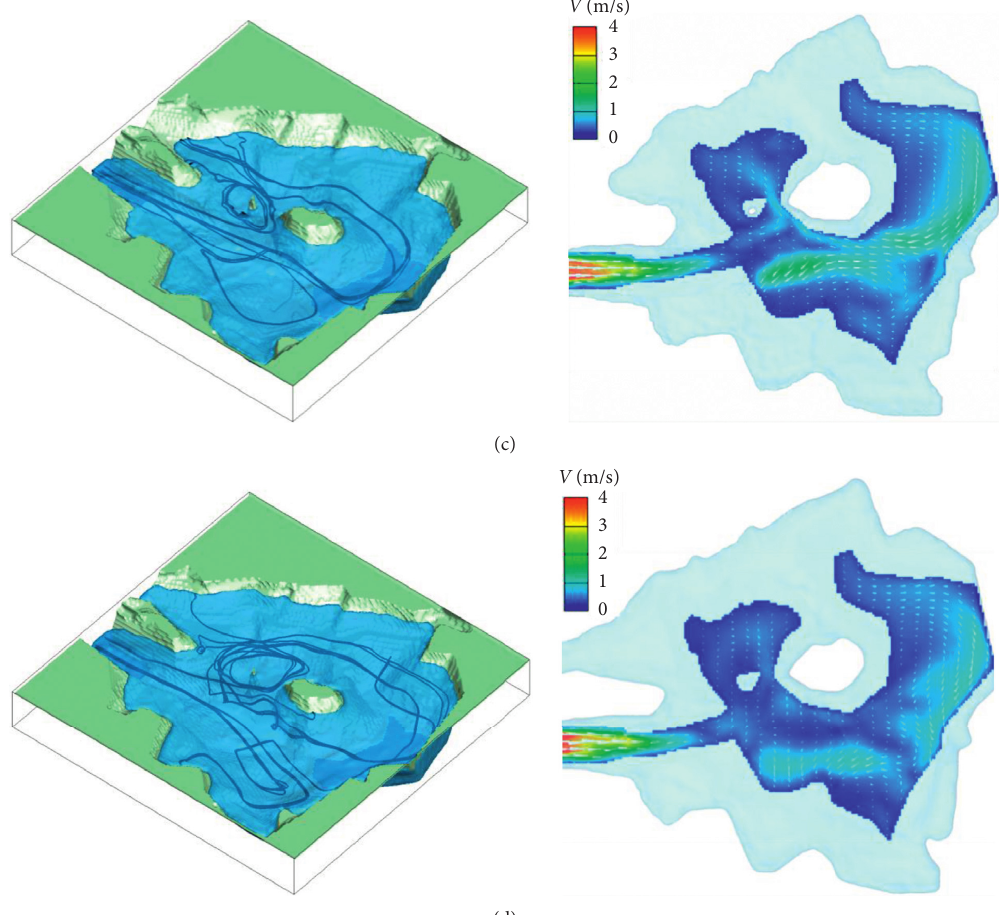
Figure 12: Water area and velocity distribution at different times: (a) t � 5min, (b) t � 15min, (c) t � 85min, and (d) t �